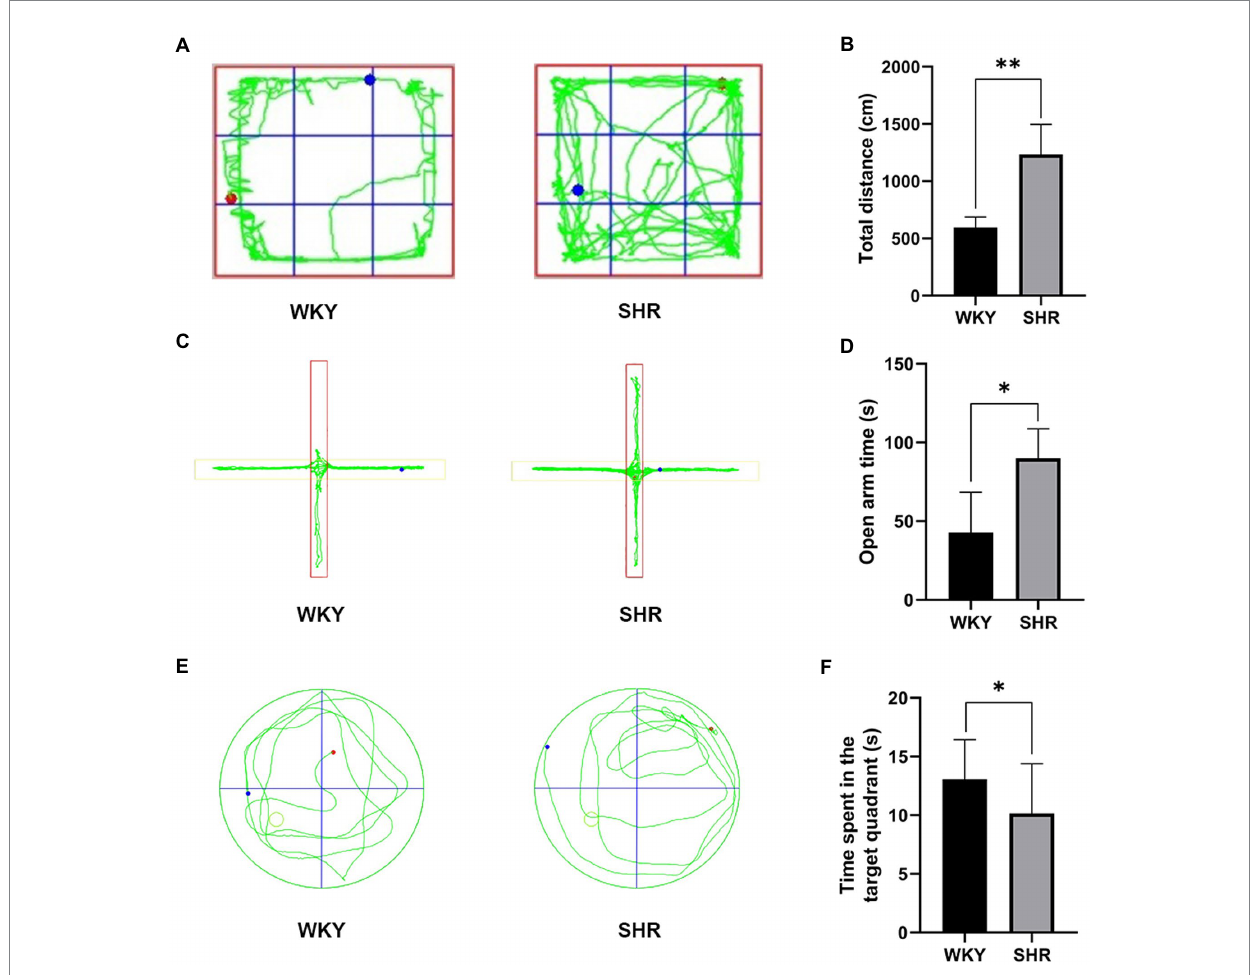
FIGURE 1 Experimental behavioral results of SHR and WKY rats. (A) Representative trajectory plots of rats in the open field test. (B) Total distance traveled by rats in the open field test. (C) Representative trajectory plots of rats in the elevated plus maze. (D) Time spent by rats in the open arm. (E) Representative trajectory plot of the rat in the water maze. (F) Time spent by rats in the target quadrant. Experimental data are expressed as mean ± SD. * p < 0.05, ** p <